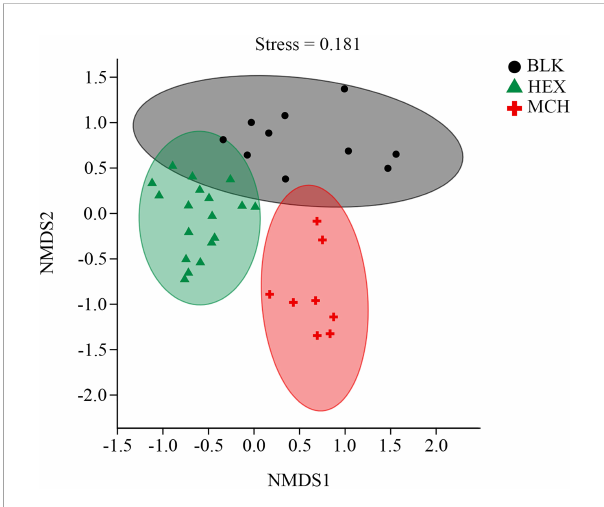
FIGURE 1 Divergence of different hydrocarbon-degrading bacterial communities derived from the CIR core sediment. The colored solid symbols denote the bacterial community structures of different treatments. MCH, methylcyclohexane-spiked enrichment cultures, and subcultures; HEX, n-hexadecane-spiked enrichment cultures, and subcultures; BLK, the original bacterial communities of the CIR core sediment without the addition of any carbon